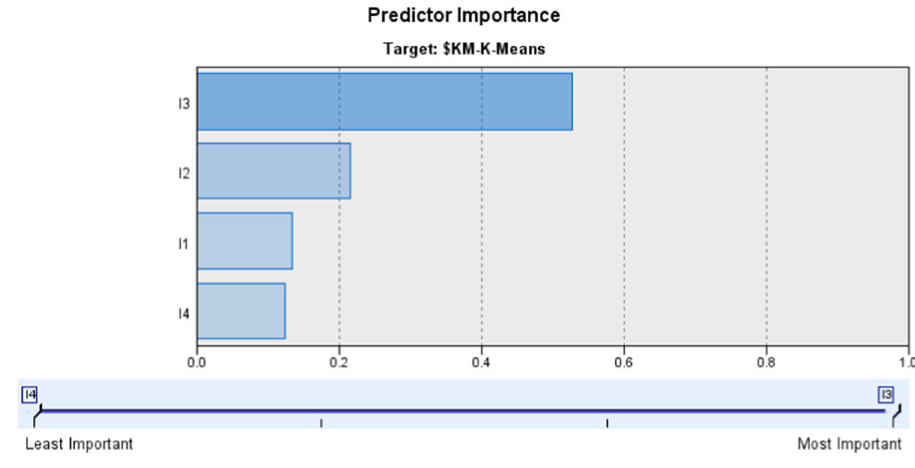
Table 16 Rules extracted between the second cluster as the consequent and the amount of irrigation in different stages of growth as the antecedent